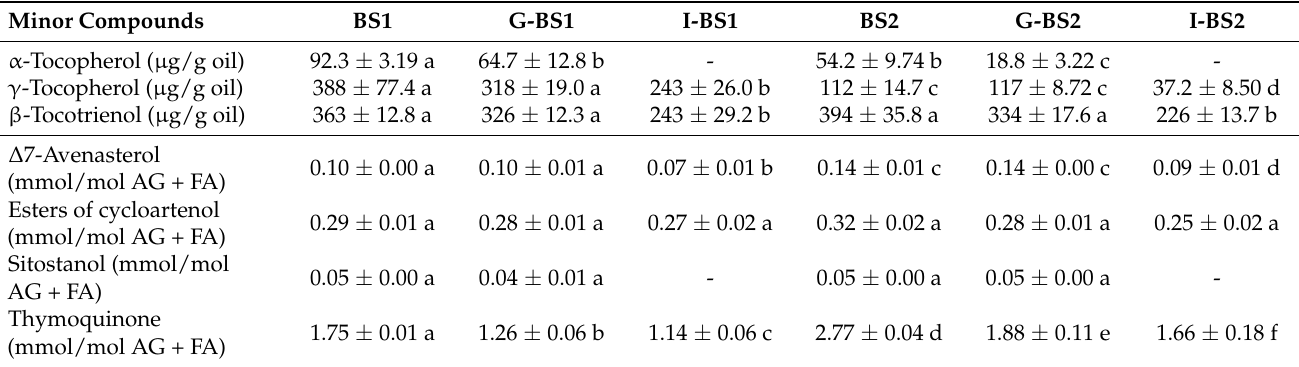
Table 3. Concentration of tocols expressed in µ g/g oil and of some sterols and thymoquinone given in molar percentage in relation to the total moles of AG+FA present in black seed oils (BS1 and BS2) and in the digestates after gastric (BS1-G and BS2-G) and intestinal (BS1-I and BS2-I) in vitro